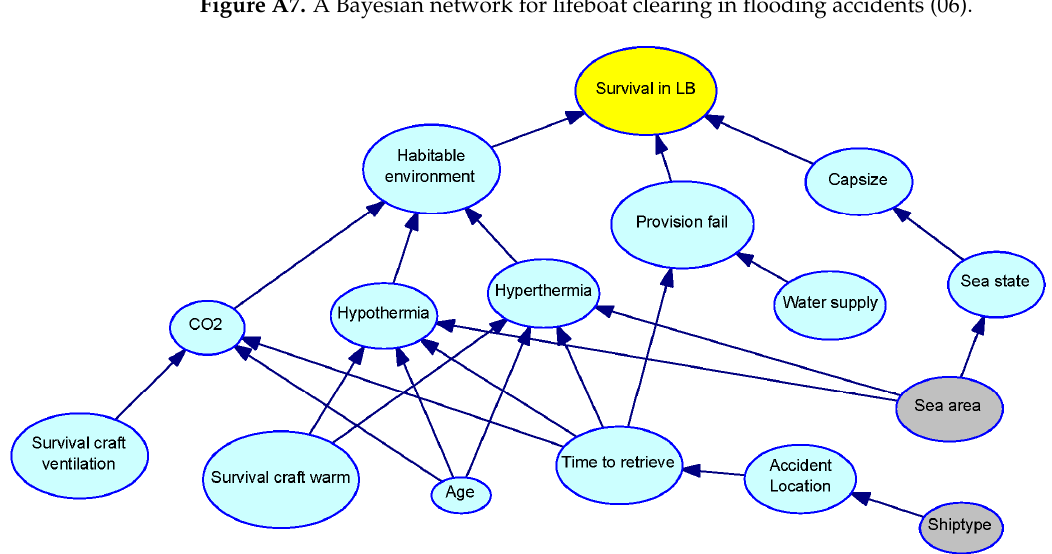
Figure A8. A Bayesian network for survival in the lifeboat in flooding and fire/explosion accidents (07).